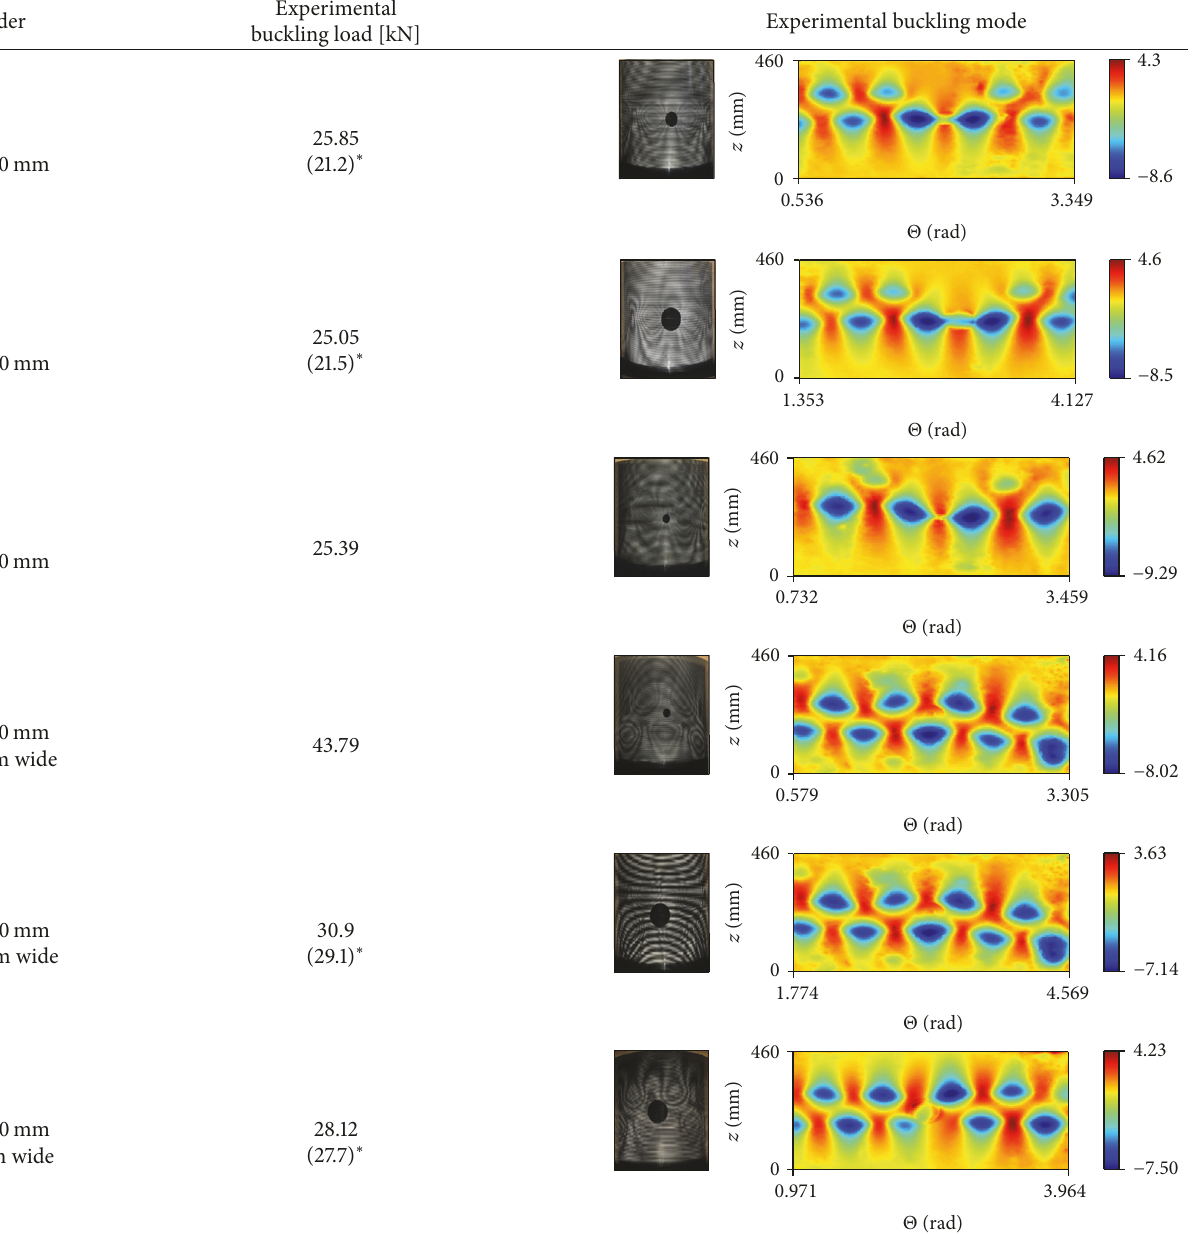
Table 3: Experimental buckling loads and mode shapes of shells with